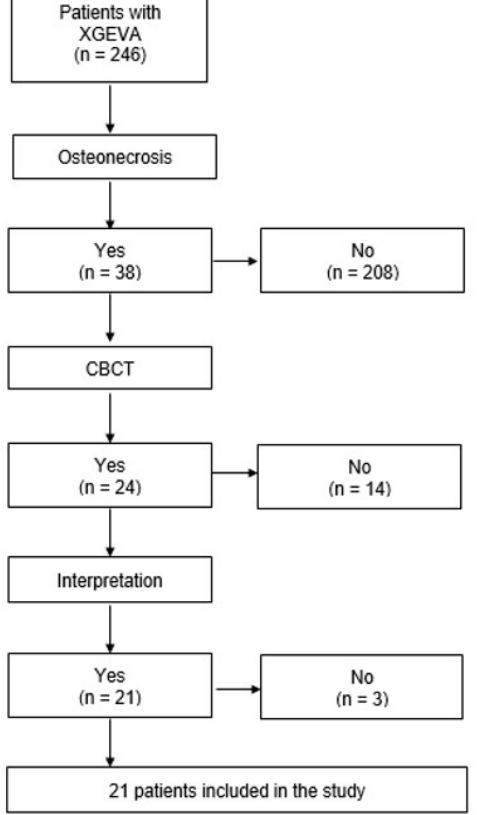
Figure 2. Selection of patients included for the comparison of clinical to radiographic extent assessed by CBCT. Table 2. Clinical characteristics of 21 patients with MRONJ and available CBCT.